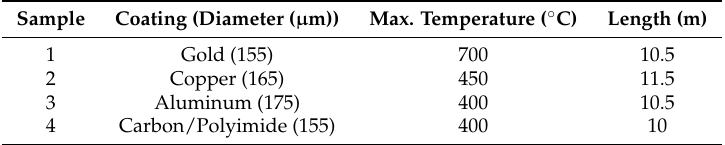
Table 1. List of tested fibers with respective coatings. Maximum operating temperature (manufacturer specification). Length of the fiber inserted into a high temperature controlled